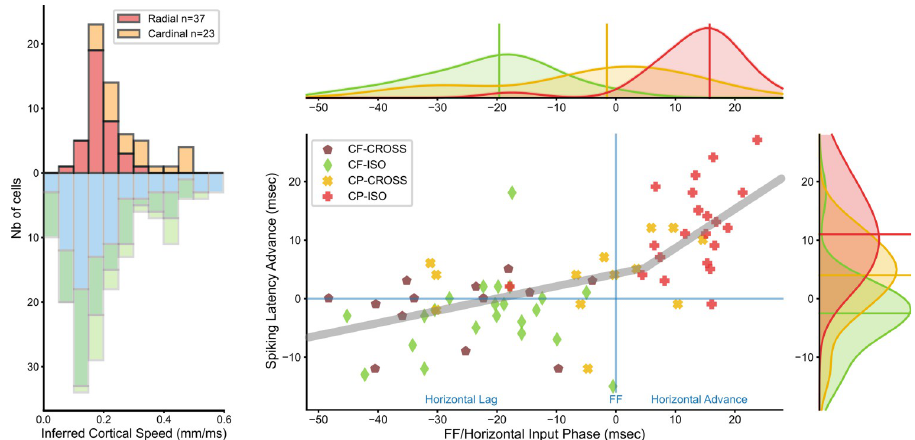
Fig 10. Causal impact of the temporal phase between feedforward and horizontal input on the spiking latency change (“cardinal” protocol). Left panel: Pooled data from the “radial” (red), and “cardinal” (orange) dynamic AM protocols (this study). Note that most apparent speed of horizontal propagation (ASHP) values, extracted from intracellular latency basin slopes with relative eccentricity, range between 0.05 and 0.60 mm/ms (with a peak between 0.10 and 0.30 mm/ms). Mirror histogram (pointing downwards): pooled data using flashed long bars (1D-mapping, blue), sparse noise mapping (green) from [26), or Gabor patches (light green). Right panel: For each individual cell recorded in the “cardinal” protocol, the latencies of Center-Only and Surround-Only Vm responses are measured and subtracted, defining the temporal phase between the “horizontal” and “feedforward (FF)” inputs. The scatter plot shows the relationship between the input phase and the resulting change in spiking latency of the recorded cell produced by the AM modulation (ordinate axis). Symbols for the centripetal conditions: “x” in gold color (CP-CROSS- parallel) and “+” symbol in red color (CP-ISO-coaligned). Symbols for the centrifugal conditions: “ � ” brown star (CF-CROSS-parallel) and green diamond (CF-CROSS-coaligned). In grey, bilinear fits. See Text for details. Note a significant reduction in spiking latency when the horizontal input is integrated post-synaptically ahead of the feedforward drive by 5–25 ms (phase advance, rightwards). The scatter plot data are projected on the x-axis (top row) or on the y-axis (right column) as Gaussian kernel density estimators (KDE). The color of each KDE distribution follows the convention of the “cardinal” visual stimulation protocol (Fig